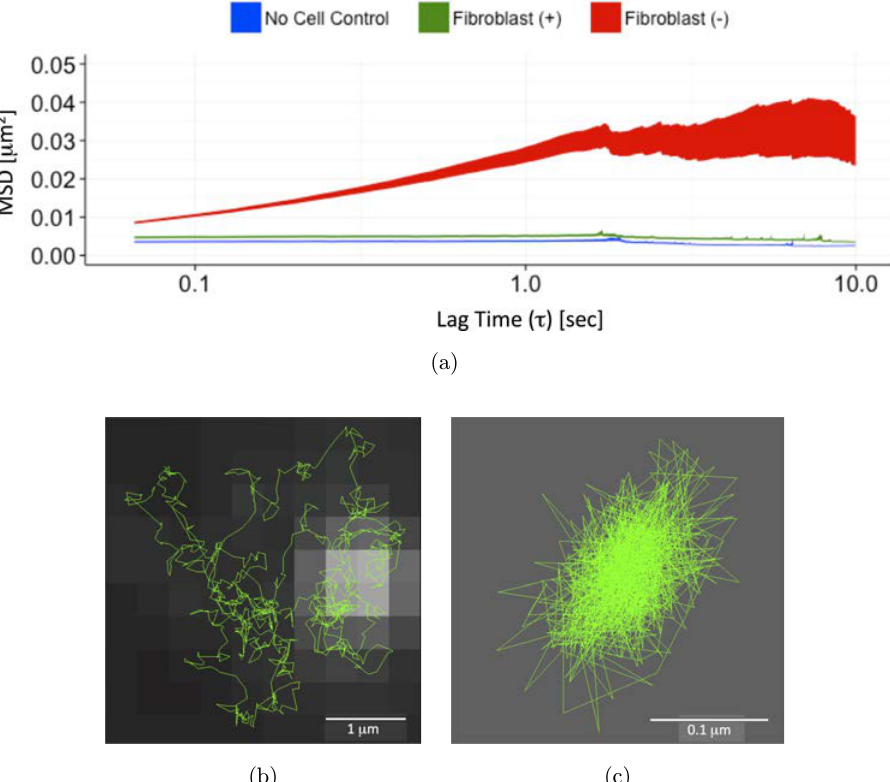
Fig. 3. (Color online) (a) MSD vs log lag-time for three populations of tracer probes, embedded in either PANC1 homoculture, PANC1 and MRC-5 coculture, or a cell-free control matrix. Probes tracked inside PANC1 cultures exhibited a much greater range of MSDs than those embedded in either of the other conditions, resulting in a steadily ampli¯ed shadow of uncertainty with increasing lag time. Generally, probe trajectories fell into two distinct categories: those with (b) \uncaged" trajectory and (c) \caged" trajectory. These two categories of probes can also be seen when plotting a histogram of log maximum displacement, revealing (d) a bimodal distribution of probe trajectories for the ¯broblast ( (cid:2) )